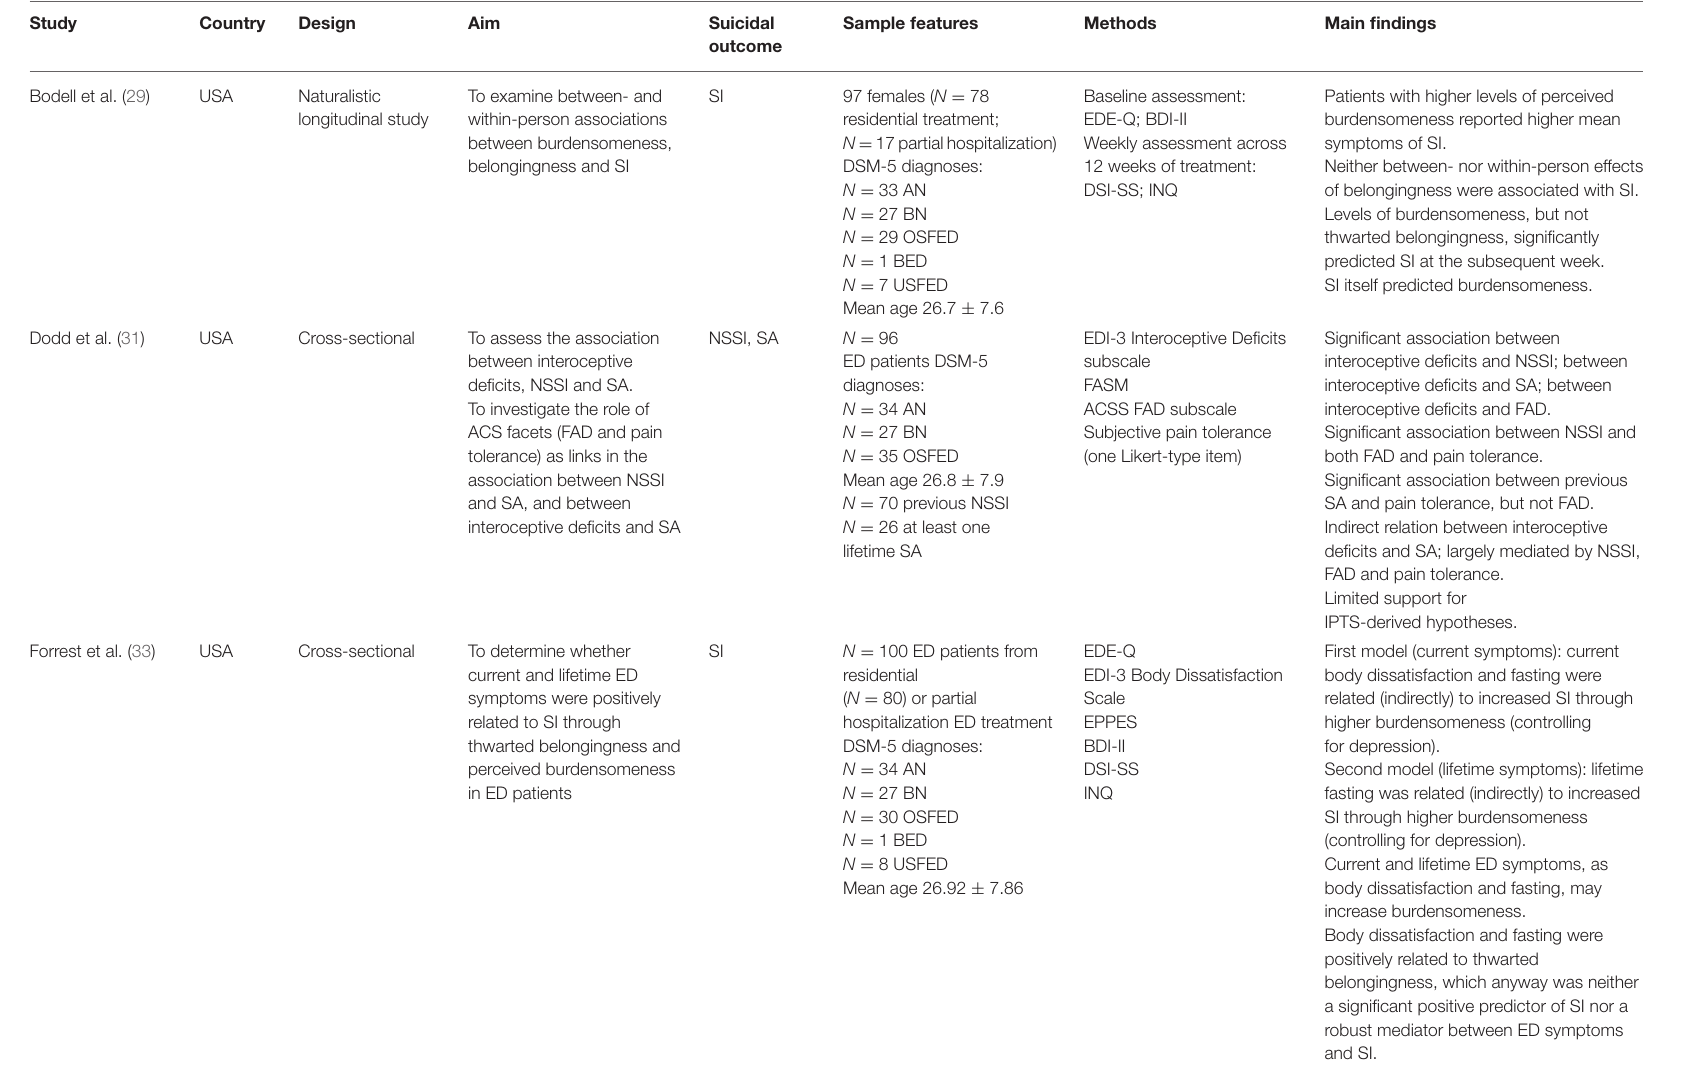
TABLE 1 | Main features of the studies included in the mini-review (listed in alphabetical